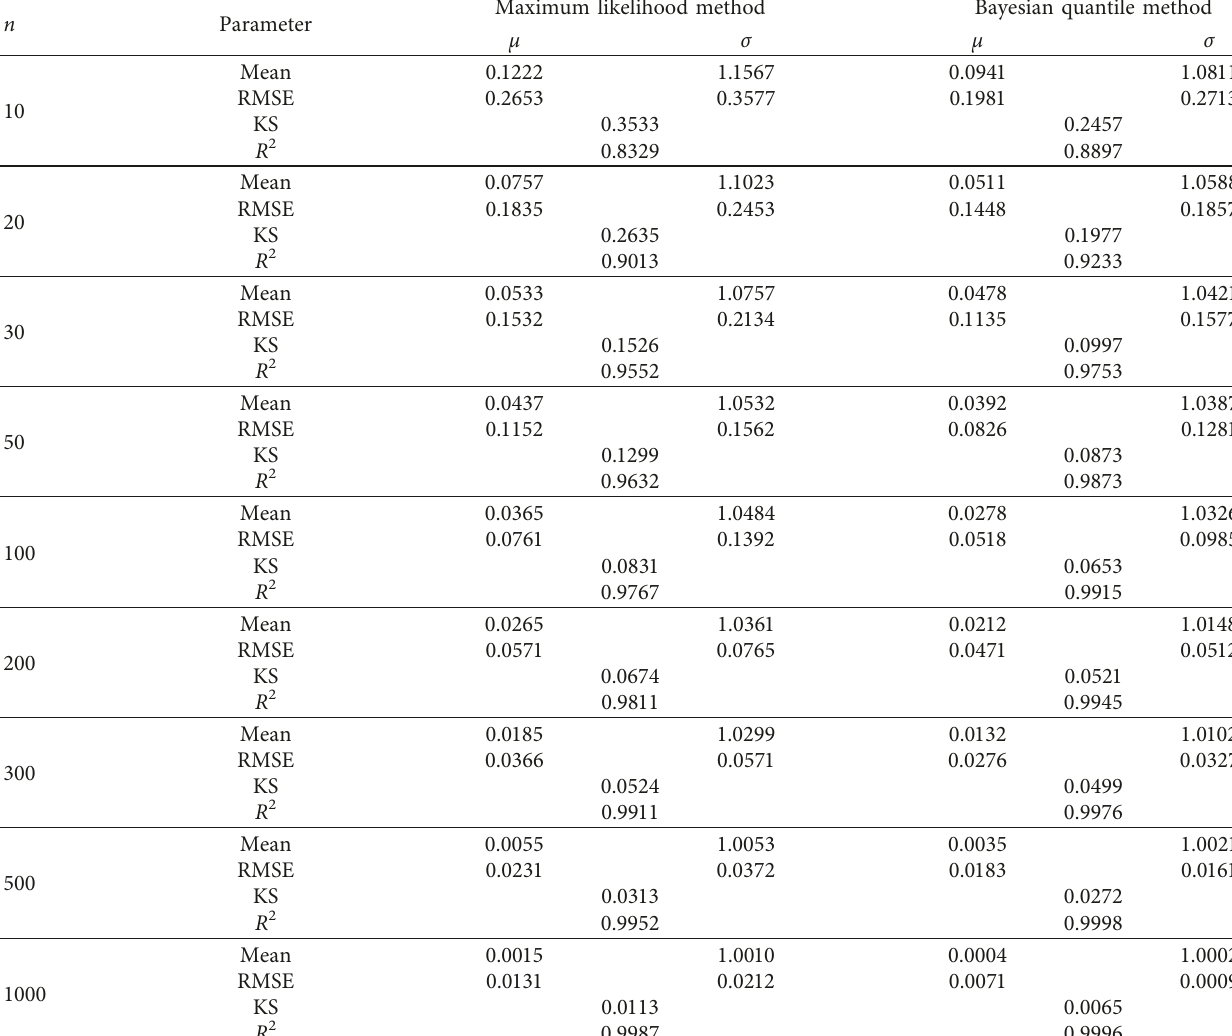
Table 1: Comparison of the estimation methods.